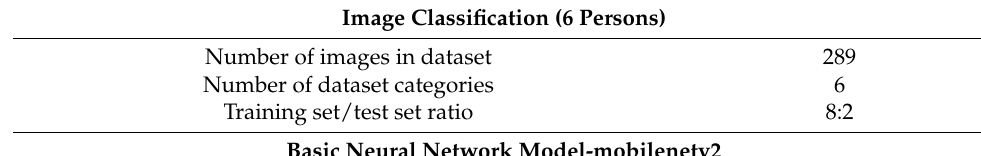
Table 1. The experimental results of image classification with diff and